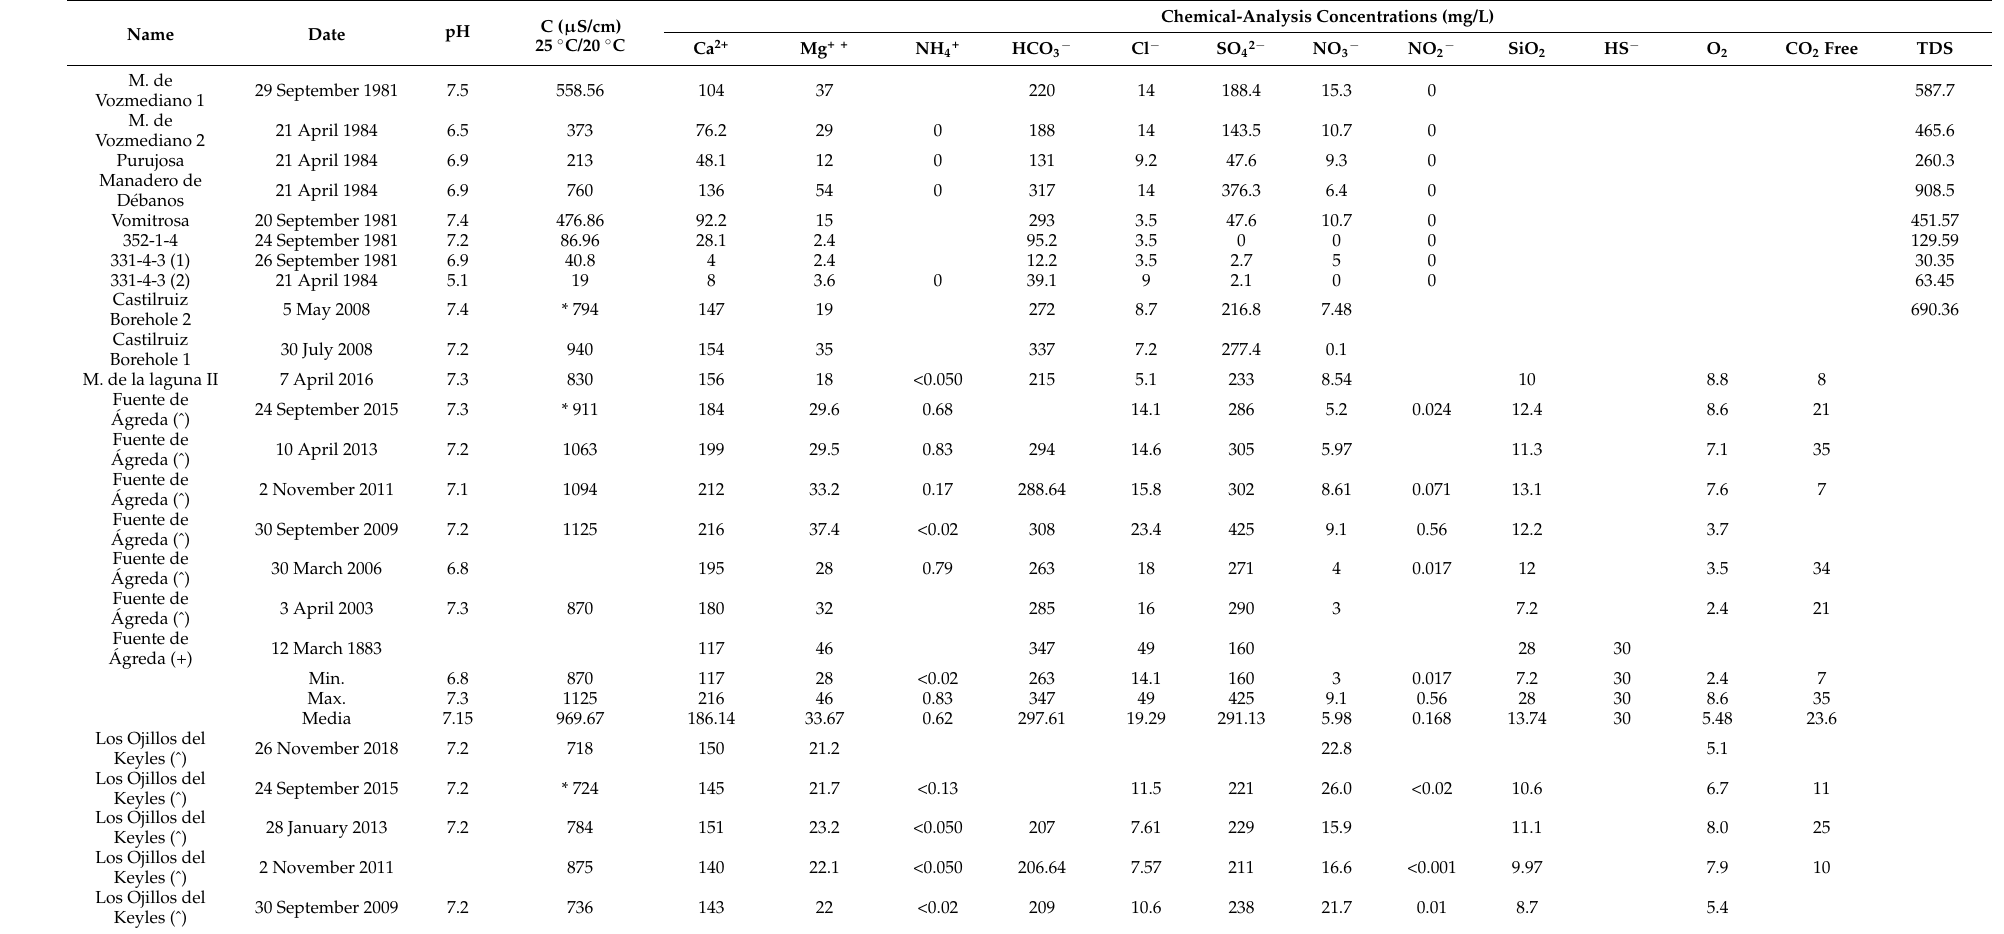
Table 1. Chemical analyses of most representative springs in the study area. Summary of major hydrochemical parameters for groundwaters ( Á